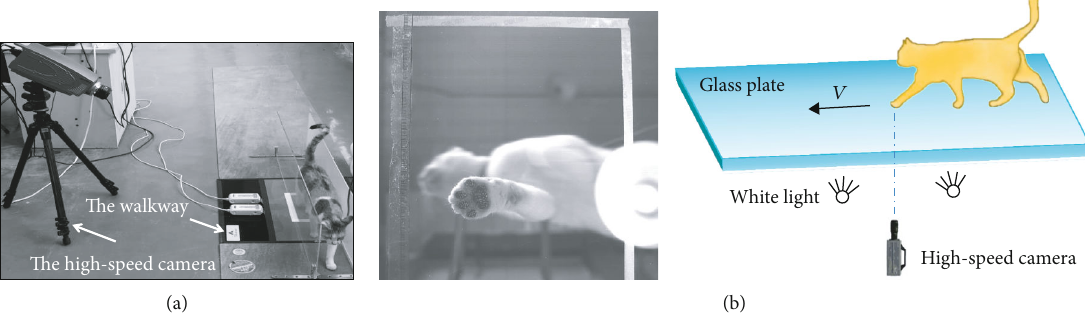
Figure 1: The contact tests of paw pads: (a) contact pressure test and (b) contact strain test.